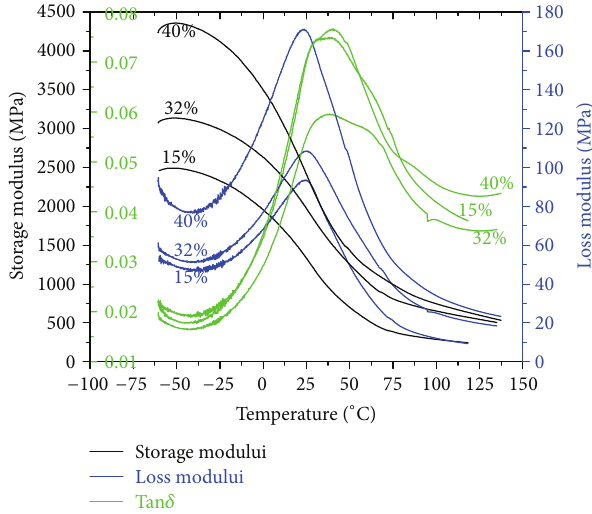
Figure 2: DMA thermogram depicting the storage modului, loss modului, and Tan 𝛿 of TCE + PTFE filled hybrid